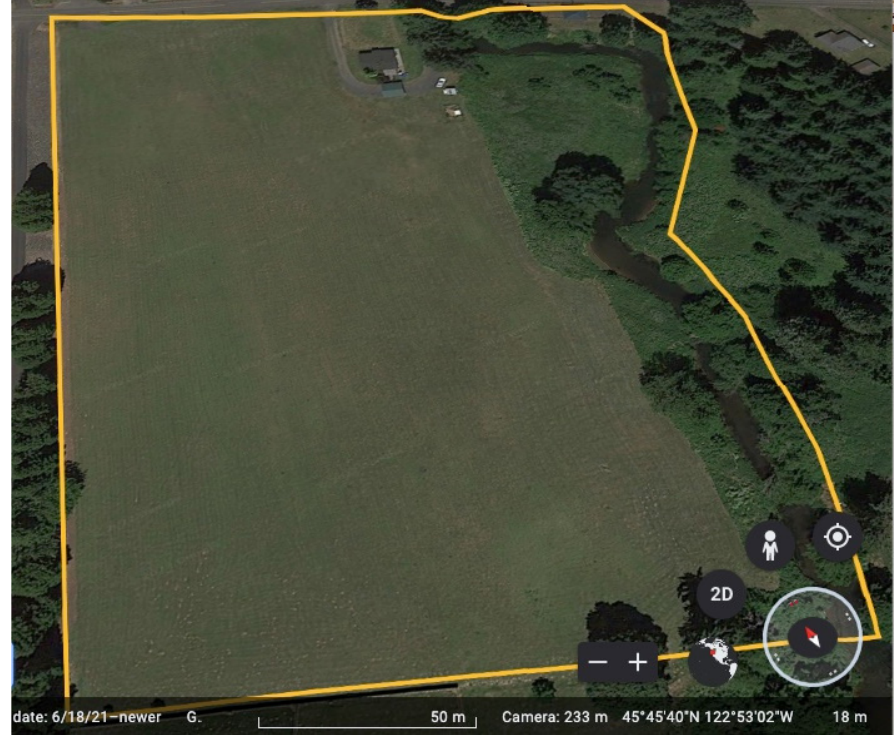
Figure 2. The undeveloped UGS boundaries and layout. (Google Earth 7.3, (2022) Scappoose Public Green Space, 45 ◦ 45 (cid:48) 36 (cid:48)(cid:48) N 122 ◦ 52 (cid:48) 55 (cid:48)(cid:48) W, elevation 13 M. [Online] Available at: http://www.google.com/earth/index.html [accessed on 30 July 2022]).